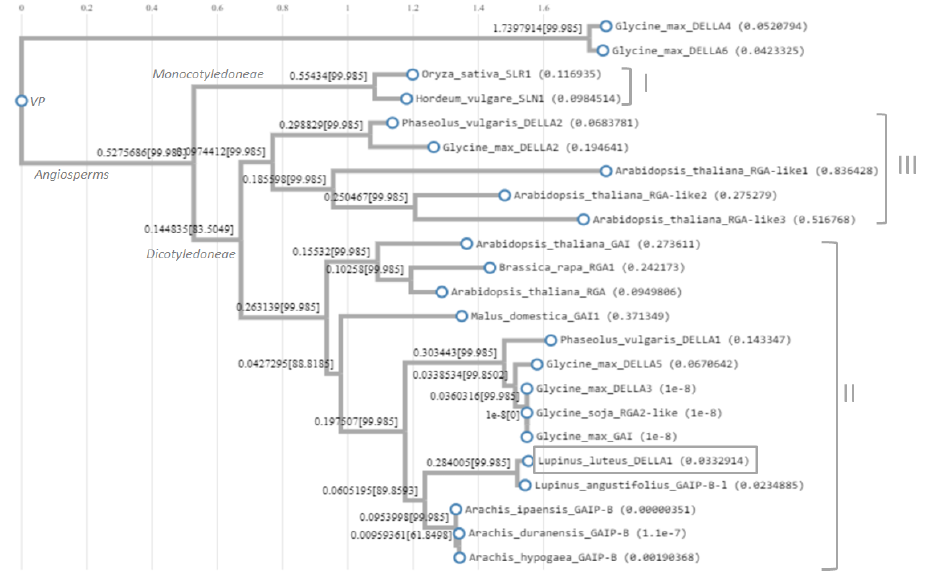
Figure 1. Maximum likelihood phylogenetic tree of 23 DELLAs derived from di ff erent plant species. Alignment and phylogenetic reconstructions were performed using Environment for Tree